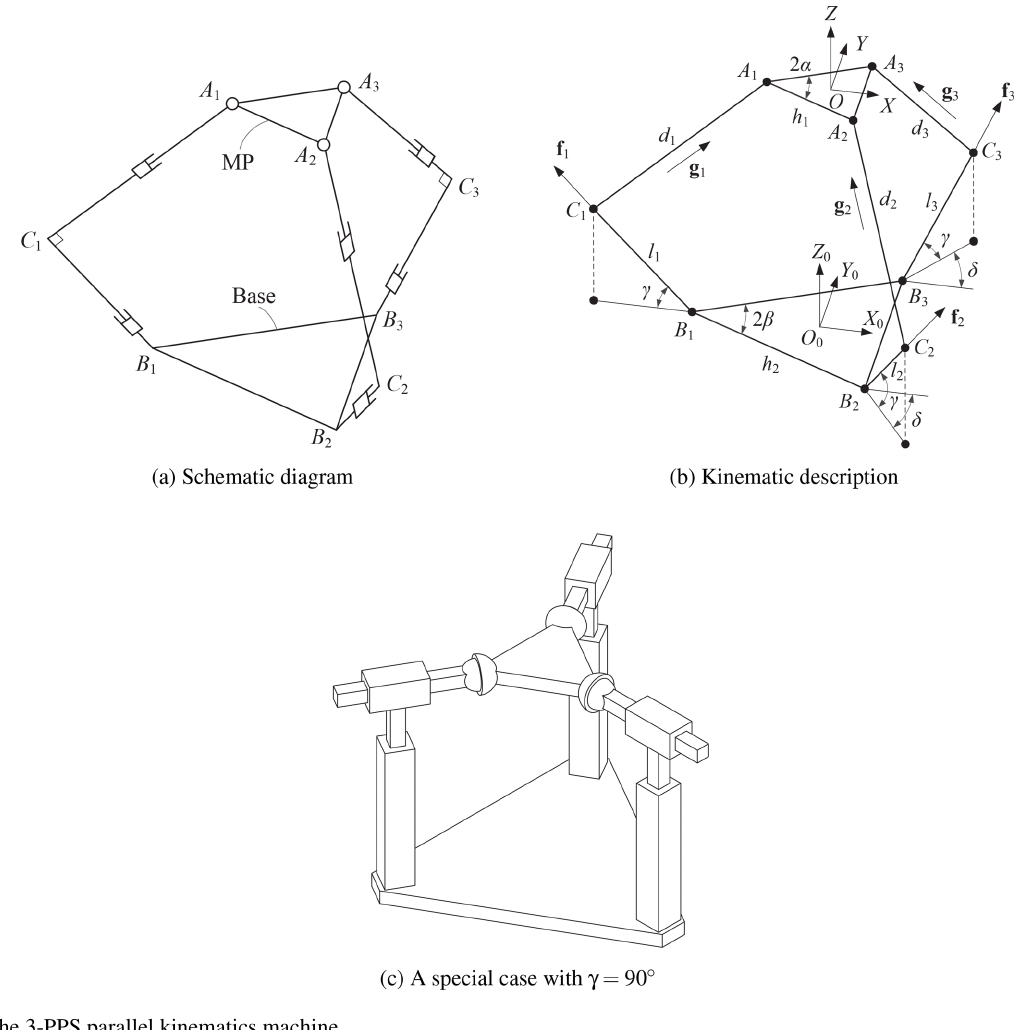
Figure 4. The 3-PPS parallel kinematics